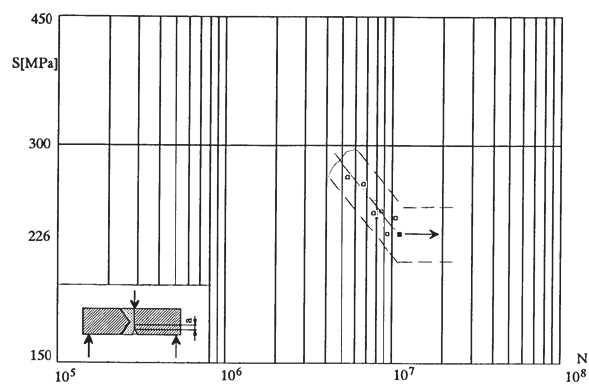
Figure 7: S-N Relationship for specimens with initial crack a= 0.782 mm.